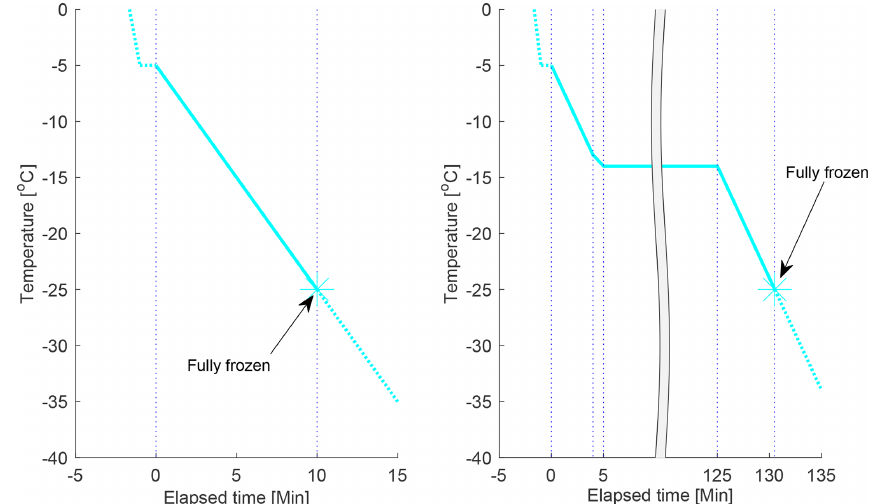
Figure 4. The cooling programmes used in this study. The cyan lines display the evolution of temperature as a function of time, the dotted blue lines indicate where the cooling rate was changed and where the experiment was completed (when the sample was fully frozen). Left panel: the cooling programme for the constant cooling rate experiments. Right panel: the cooling programme used for the 2h isothermal experiments. One isothermal experiment with a longer isothermal period (11–16h) was also done on each drop population (not shown). In this figure, the timescale starts ( t = 0) at the first cooling ramp after the 1min pause at − 5 ◦ C; all times are referred to in the analysis for the isothermal experiments are from the start of the isothermal phase, if nothing else is specifically